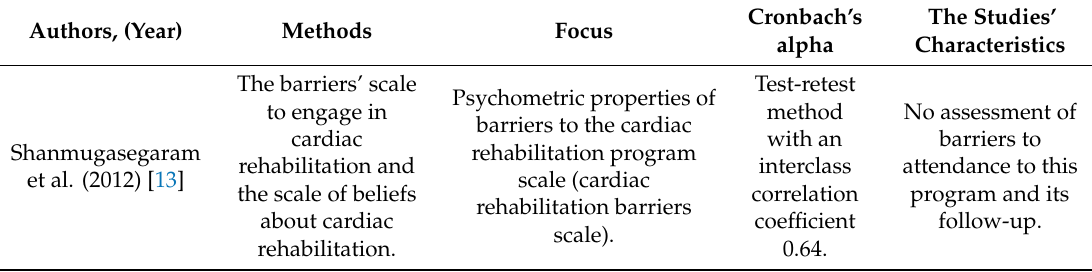
Figure 1. The progression of the search strategy according to the PRISMA. Table 1. Available instruments of patients’ participation and adherence to cardiac rehabilitation .